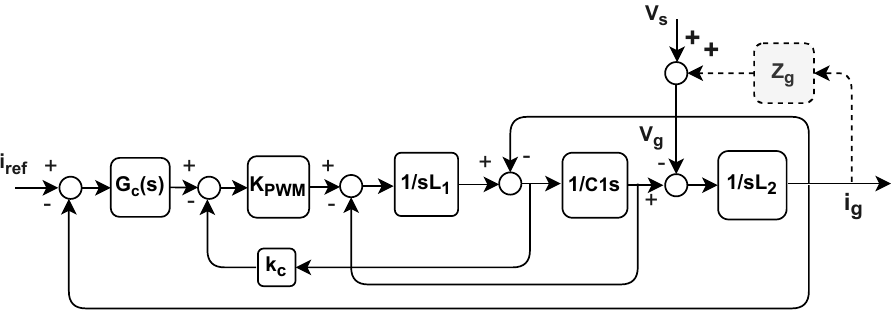
The average switch control model block diagram of the grid-tied inverter is given in Figure 2. The capacitor of the LCL filter generates a resonance which makes the system unstable. The feedback loop having gain k c is used for active damping. The (1) represents its mathematical form.